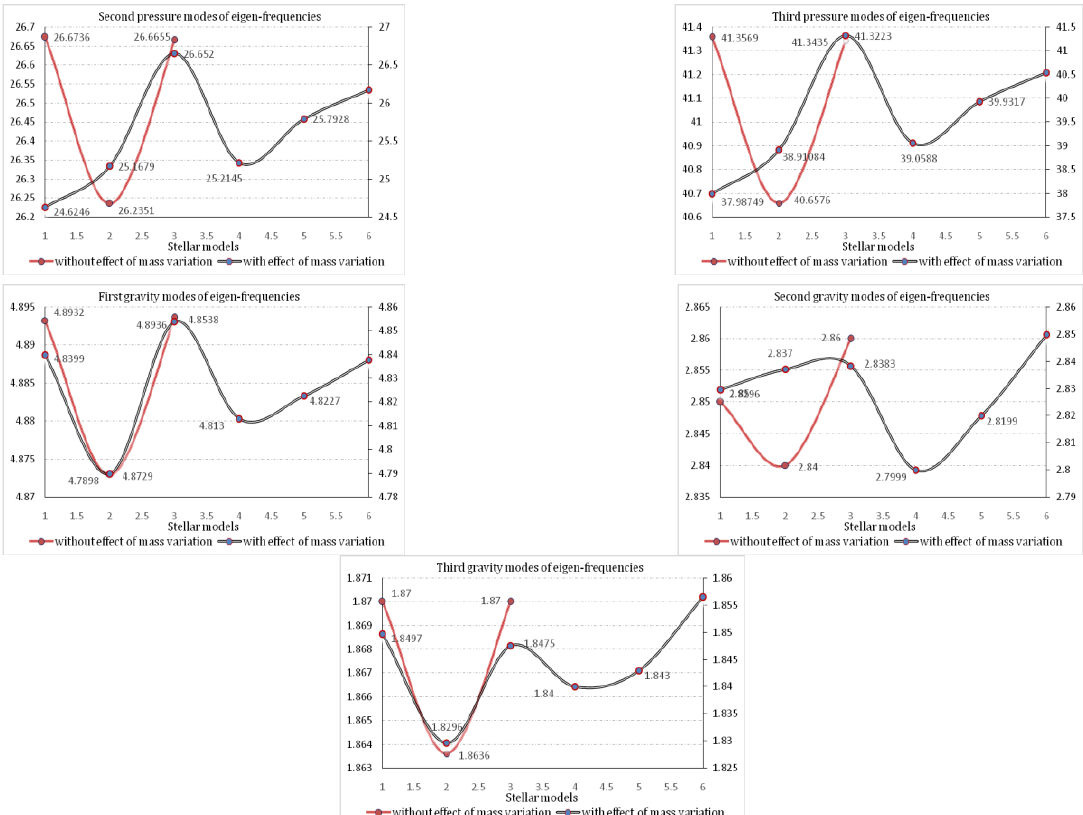
Figure 2. Eigen-frequencies of polytropic stellar models of polytropic index